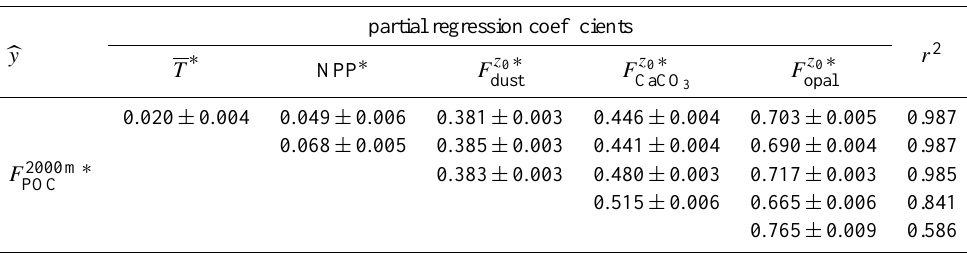
Table 3. Standard partial regression coefficients and coefficients of determination (r 2 ) for stepwise multivariate linear regression of stan-